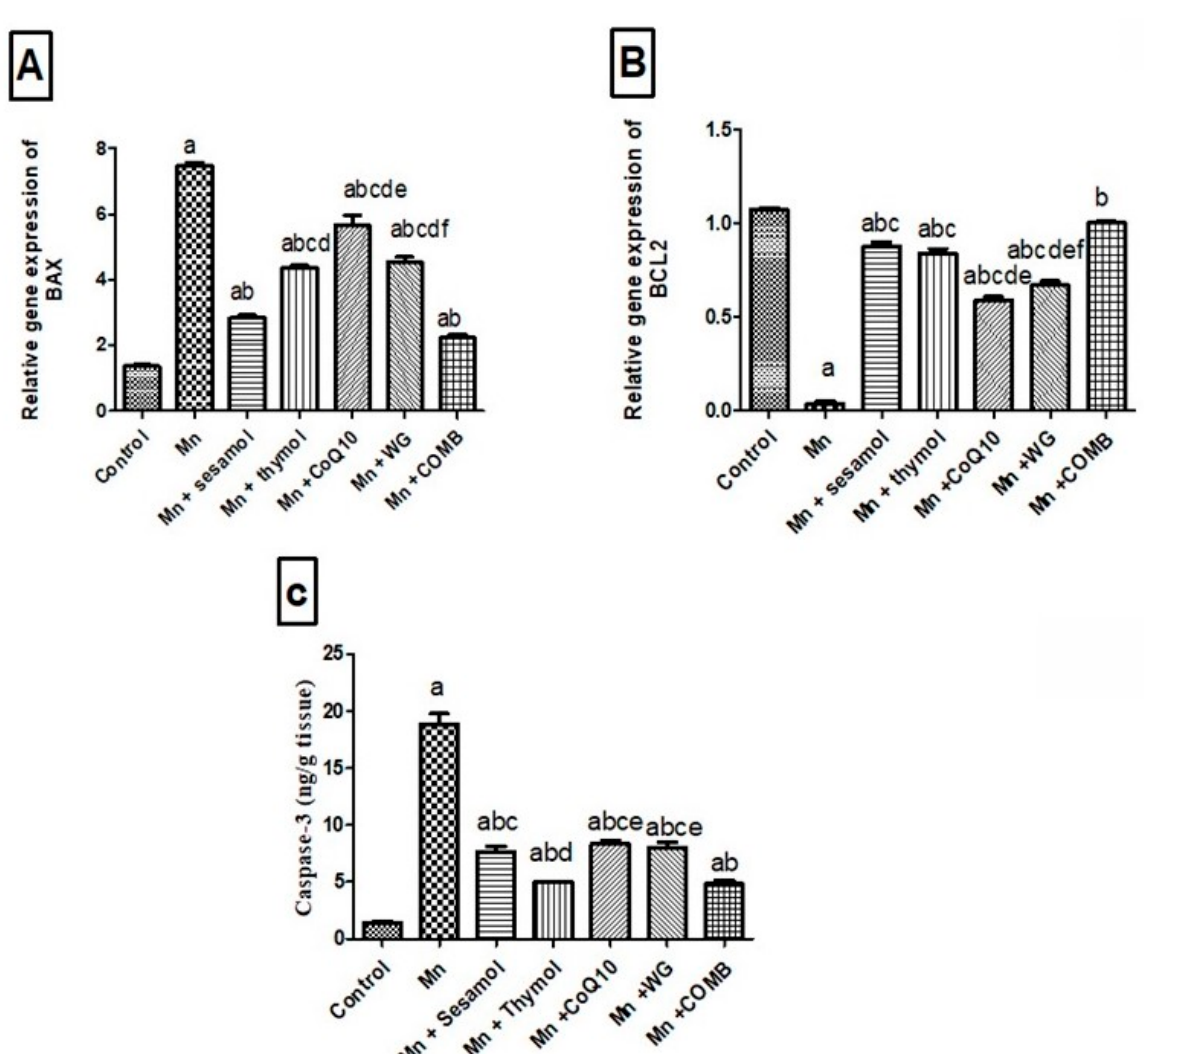
Figure 7. Effects of sesamol, thymol, CoQ10, wheat grass, or their combination on MnCl 2 -induced changes in ( A ) Bax mRNA expression level, ( B ) Bcl2 mRNA expression level, and ( C ) caspase-3 protein content. Values are means of 8 rats ± S.E.M, as compared with control (a), Mn (b), COMB (c), sesamol (d), thymol (e), and CoQ10 (f) groups. One-way ANOVA with posttest Tukey’s multiple comparison assessed the statistical differences between the various groups, p -value < 0.05.